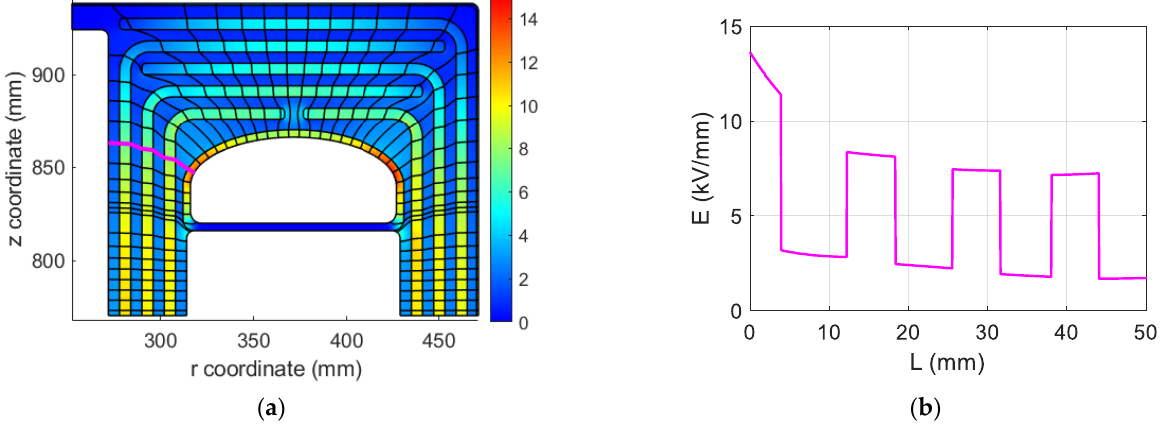
Figure 11. The streamlines by using ester oil at 10 s and 30 °C: ( a ) A sample streamline (thick pink line); ( b ) The electric field curve along this streamline starting from the rightmost point.